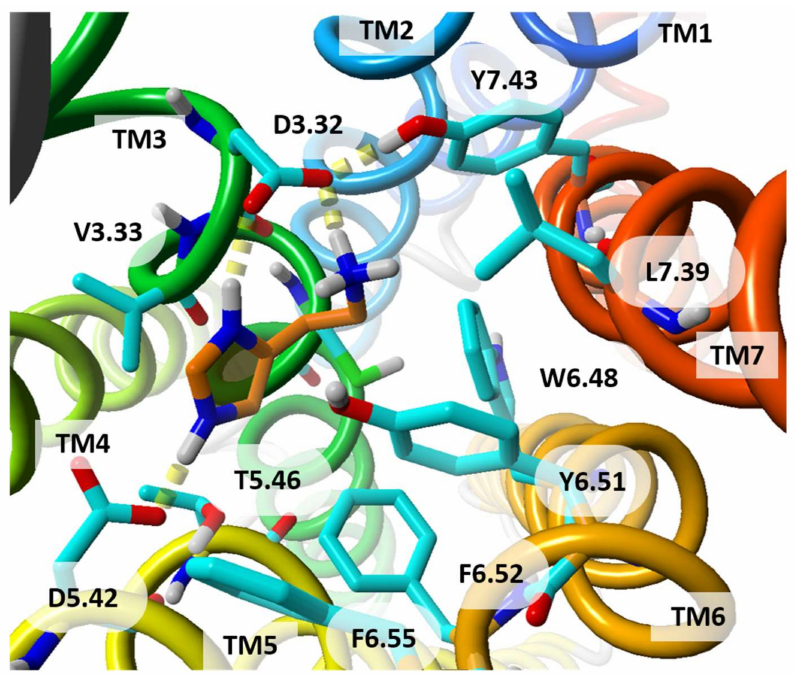
Figure 5. Histamine molecule docked to the homology model of hH 2 R. The histamine is doubly positively charged. Both charged moieties of histamine are bound to D 3.32 . The imidazole ring is additionally bound to D 5.42 . The residue numbers are shown in Ballesteros-Weinstein numbering scheme. Histamine is shown with its carbon atoms colored in orange. View from extracellular side. TM helices are colored from blue (TM1) to red